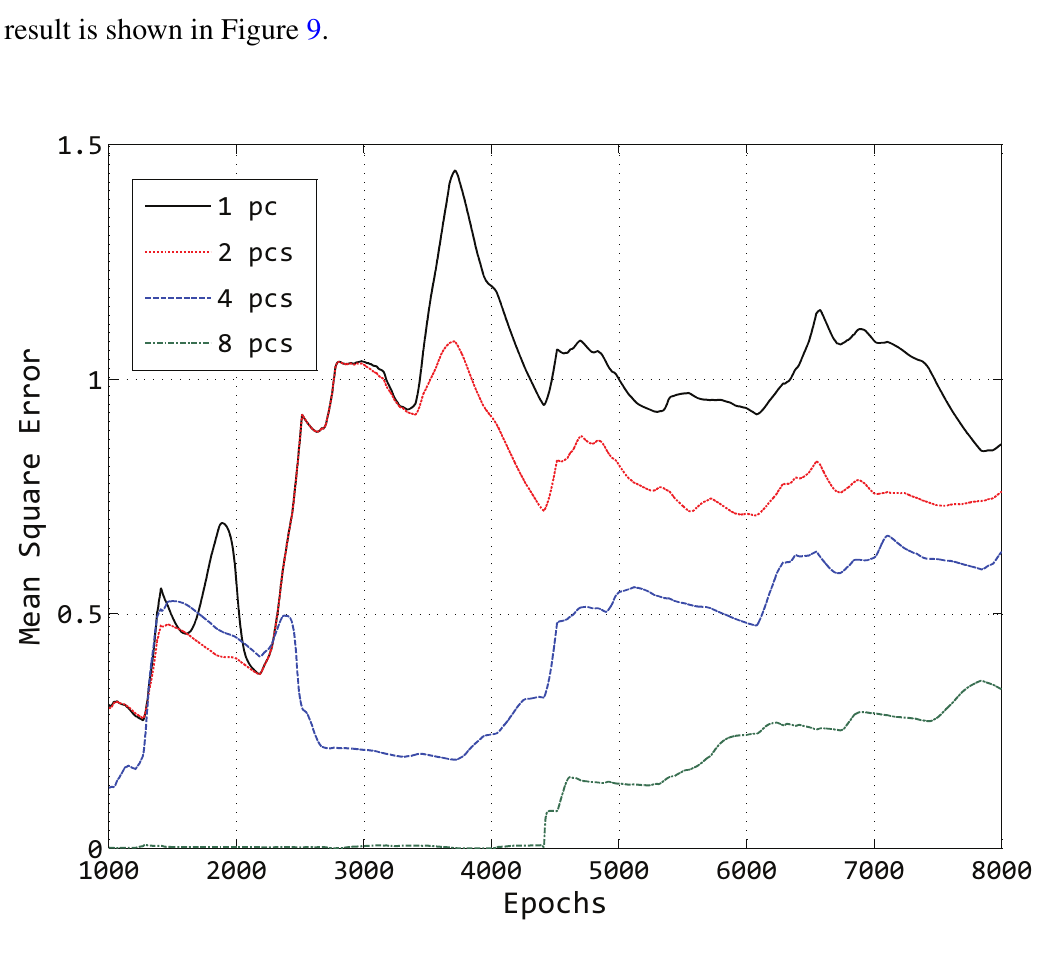
Figure 9. Mean square error of reconstructed data of Sensor